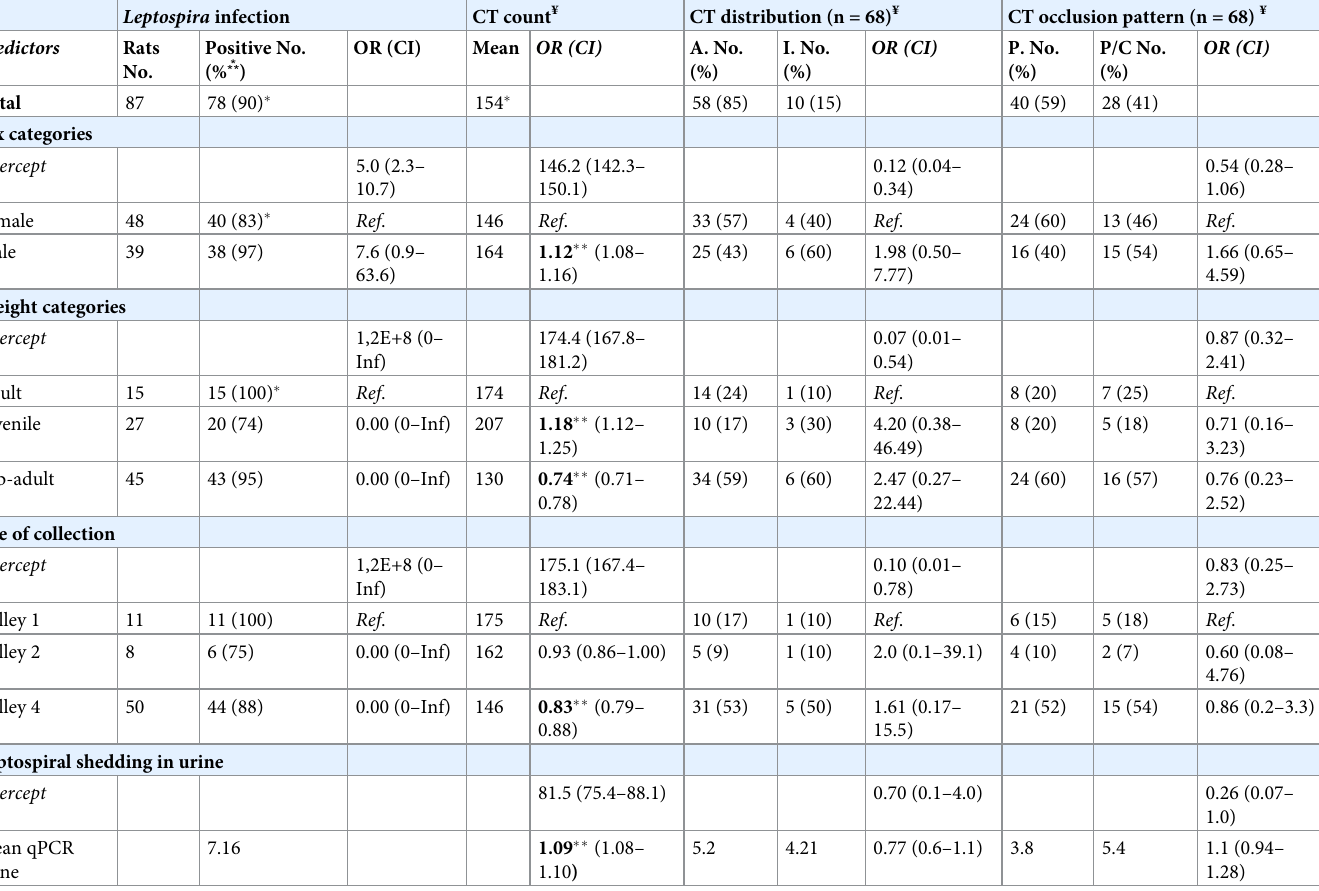
Table 3. Demographic characteristics, patterns of renal colonization and Leptospira shedding in wild Rattus norvegicus (Norway rat) naturally